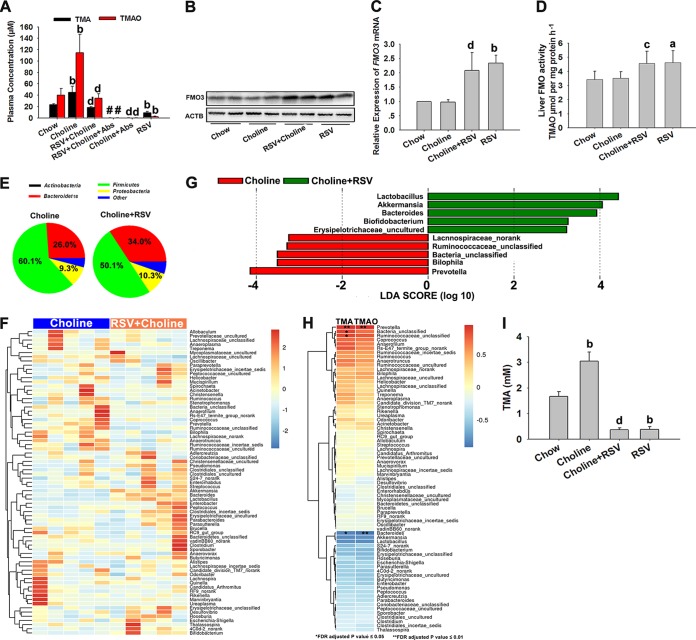
RSV reduced TMAO levels by decreasing TMA generation via remodeling microbiota in ApoE−/− mice. Eight-week-old female ApoE−/− mice (n = 5 per group) were fed chow, chow with RSV (0.4%), chow with choline (1%), or chow with choline (1%) plus RSV (0.4%) in the absence or presence of Abs for 4 months. (A) Serum TMA and TMAO levels were measured by LC/MS. (B) Western blotting detection of FMO3 expression in the liver. (C) Expression levels of FMO3 gene mRNAs were quantified using qPCR assays. (D) Liver FMO activity was assessed as described in Materials and Methods. (E) 16S rRNA gene sequencing analysis of cecal content at the phylum level. (F) Heat map of 16S rRNA gene sequencing analysis of cecal content at the genus level. The scale reflects the data as follows: red indicates high values whereas blue indicates low values for the spercentage of reads that were classified at that rank. (G) Linear discriminant analysis (LDA) coupled with effect size measurements identifies the most differentially abundant taxons at the genus level between the choline diet and the RSV-plus-choline diet. RSV-plus-choline-diet-enriched taxa are indicated with a positive LDA score (green), and taxa enriched in the choline diet have a negative score (red). Only taxa meeting an LDA significance threshold of >2 are shown. (H) Correlation heat map demonstrating the association between the indicated microbiota taxonomic genera and TMA and TMAO concentrations (all reported as means ± SD in micromoles) from mice grouped by dietary status (choline and RSV plus choline). Red denotes a positive association, blue a negative association, and white no association. A single asterisk indicates a significant FDR-adjusted association of P values of ≤0.05, and a double asterisk indicates a significant FDR-adjusted association of P values of ≤0.01. (I) Production of TMA from choline by cecal content in vitro. Values are expressed as means ± SD (n = 5). a, P < 0.05; b, P < 0.01 (versus vehicle-treated control group); c, P < 0.05; d, P < 0.01 (versus choline-treated group); #, P < 0.05 (versus group cotreated with RSV and choline).